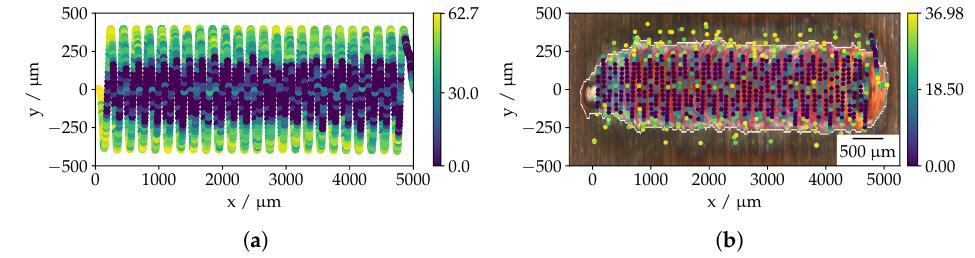
Figure 12. ( a ) OCT movement path and Intensity in an x-y-plane during a welding process; ( b ) weld seam image overlaid with corresponding OCT movement path and thresholded